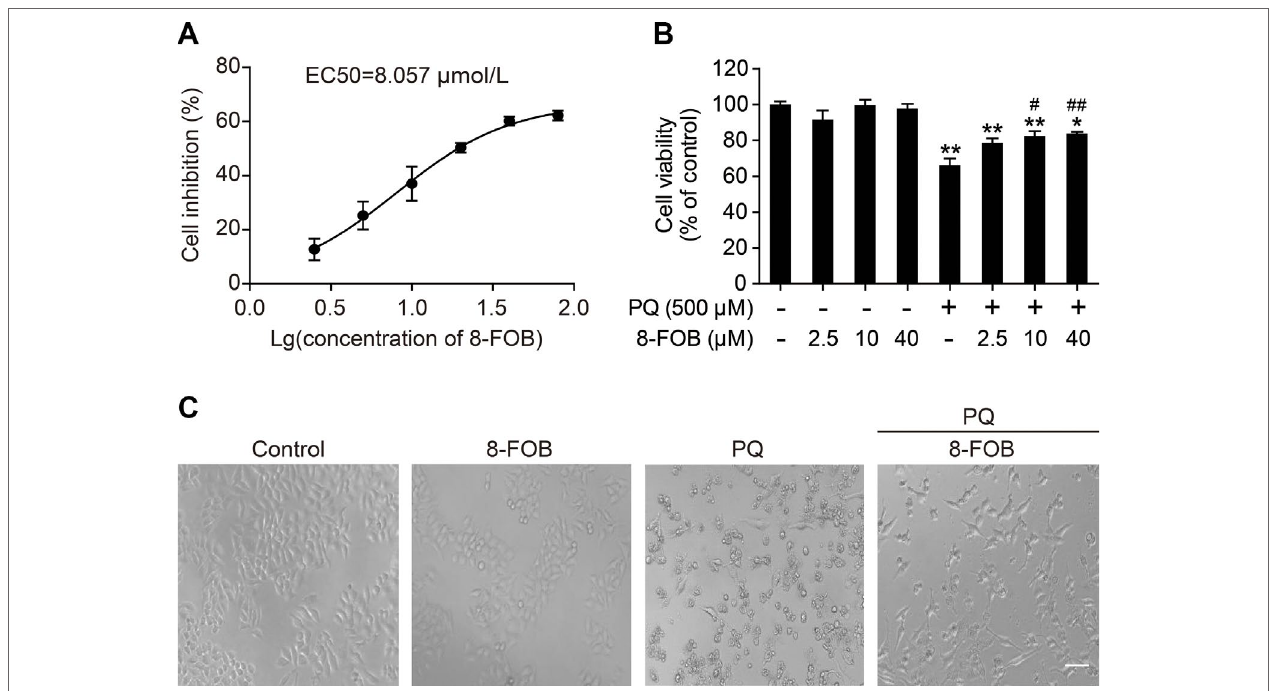
FIgURe 2 | 8-Formylophiopogonanone B (8-FOB) suppresses paraquat (PQ)-induced cytotoxicity in L02 cells. (A) Fitted curve showing the inhibition of cytotoxicity by 8-FOB. The EC50 value of 8-FOB for the protection against PQ toxicity in L02 cells was 8.057 μM. (B) The effect of pretreatment with different 8-FOB concentrations on cell viability in the presence of 500 μM PQ. The values are presented as the means ± SEM ( n = 6). * p < 0.05, ** p < 0.01 vs control group; # p < 0.05, ## p < 0.01 vs the PQ group. (C) Representative images showing the effects of 8-FOB pretreatment on cell damage induced by 500 μM PQ. Scale bar: 80